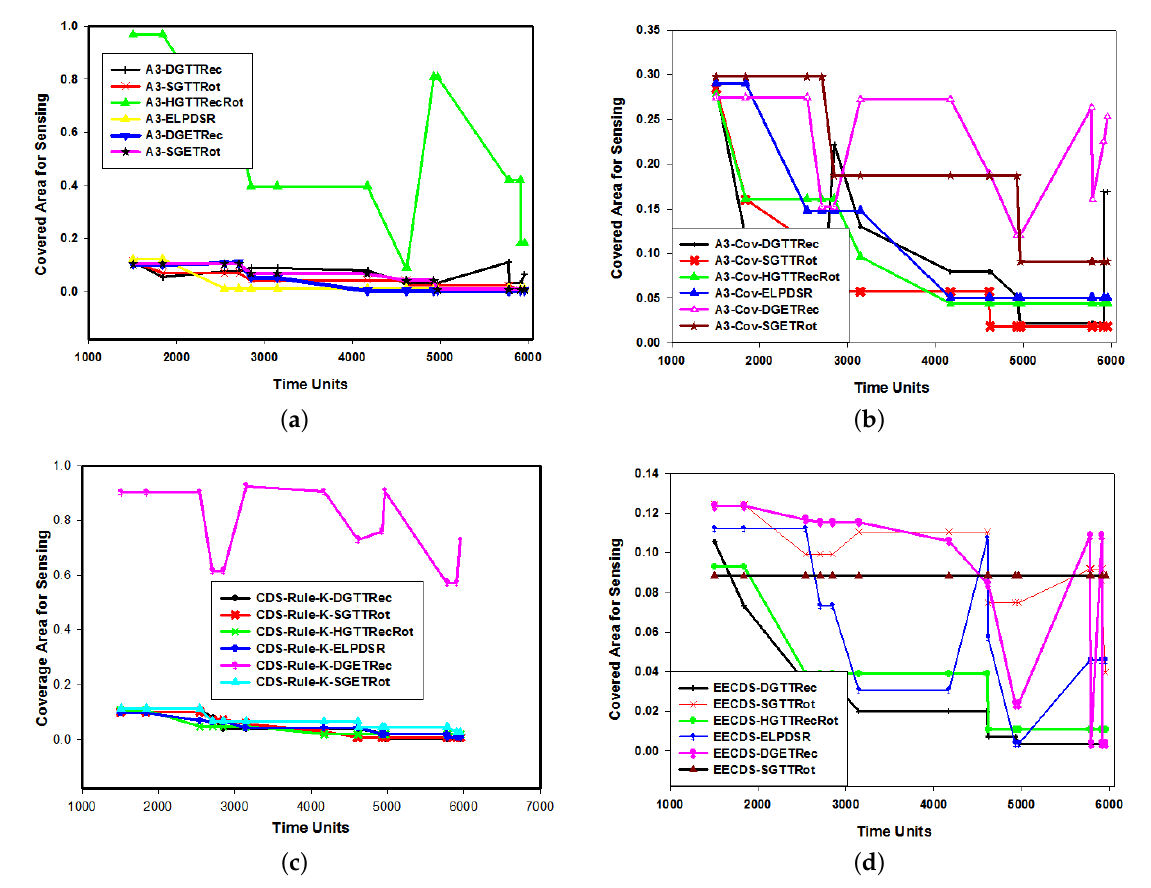
Figure 9. Topology maintenance for sensing coverage area using ( a ) A3, ( b ) A3-Cov, ( c ) CDS-Rule-K and ( d ) EECDS